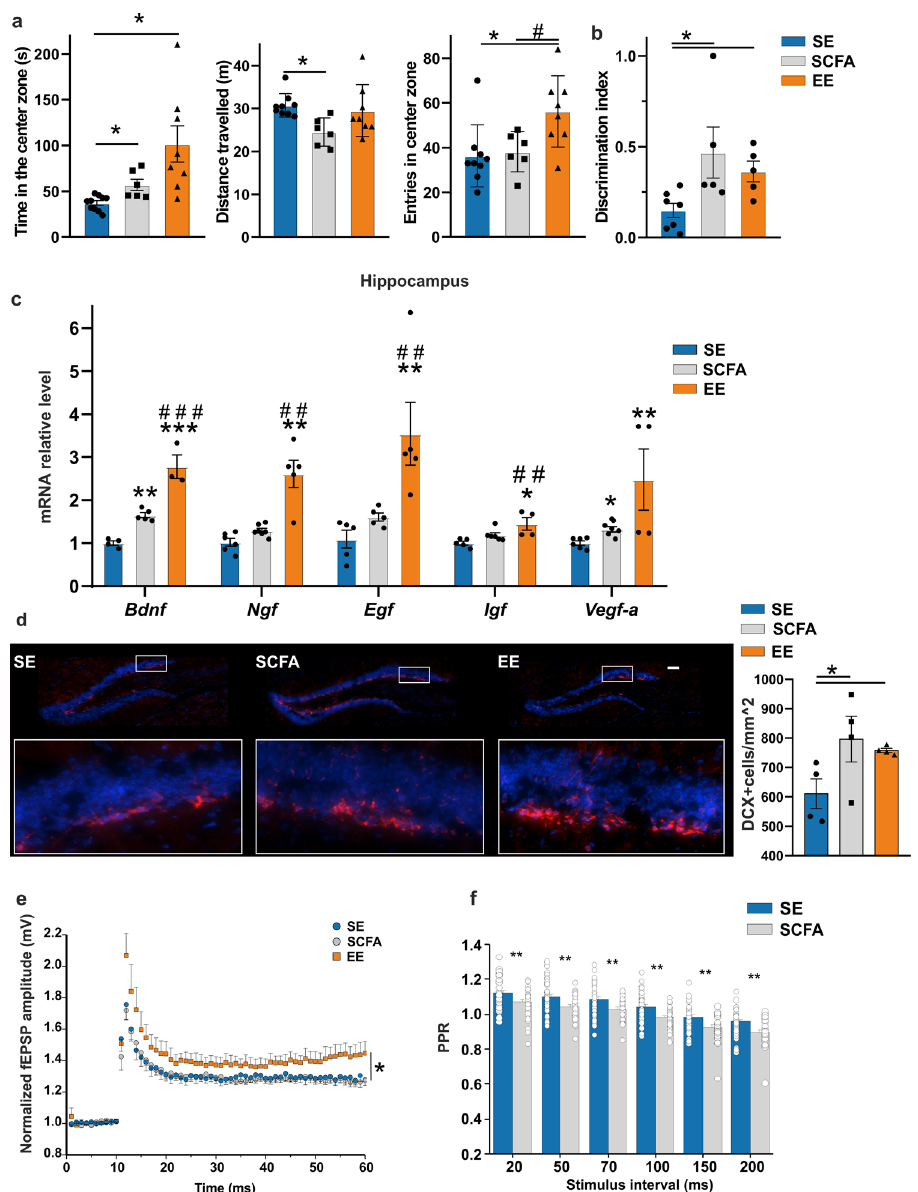
Fig. 3 Formate and acetate administration induces brain plasticity in EE-housed mice. a Open fi eld test for mice SE, treated with SCFA (150 mM sodium formate and 62.5 mM sodium acetate) or exposed to EE environment for 5 weeks: left panel, time (in seconds) spent in the center zone; central panel, distance traveled (in meters) during the test; right panel, number of entries in the center zone (* p -value < 0.05 vs SE; # p -value < 0.05 vs SCFA. Data are the mean ± S.E.M.). b Novel object recognition test for SE, SCFA and EE mice. The discrimination index was calculated as the amount of time spent exploring the novel object relative to the familiar object, divided by the total amount of time exploring both objects. SCFA and EE mice performed better than controls (* p -value < 0.05 vs SE. Data are the mean ± S.E.M.) c RT-PCR of hippocampal neurotrophins ( Bdnf, Ngf, Egf, Igf, Vegf-a ) in SE, SCFA- or EE treated mice (*** p < 0.001; ** p < 0.01; * p < 0.05 vs SE; ### p < 0.001; ## p < 0.01 vs SCFA. Data are the mean ± S.E.M.). d Representative 20x magni fi cation of mouse hippocampal dentate gyrus (DG) coronal sections stained for DCX (red) and Hoechst (blue) of SE, SCFA- and EE treated mice (scale bar, 100 μ m). The highlighted squares illustrate the DG regions digitally ampli fi ed where DCX + cells are shown. Right, bar graphs showing the number of DCX + cells for mm 2 in the DG of the three groups (* p -value < 0.05 vs SE. Data are the mean ± S.E.M.). e Field excitatory postsynaptic potentials (fEPSPs) recorded from the CA1 region of hippocampus of SE (blue), SCFA (gray), or EE (orange) mice following Schaffer Collateral high frequency stimulation (100 Hz, of 1 s duration, arrow). Points represent mean (± SEM) of normalized fEPSP amplitude slopes evoked every 20 s (* p < 0.05). f Paired-pulse ratio (PPR) for 20-50-70-100-150-200 ms inter-stimulus intervals. Bar histograms represent averaged values for SE and SCFA (** p < Dunnett ’ s post-hoc test) compared to SE (1.28 ± 0.03, n/N = 11 gut metabolites, we recorded the LTP induced by 100 Hz biologically independent samples/4 biologically independent stimulation of Schaffer Collateral inputs comparing control with animals), whereas EE mice have signi fi cantly increased LTP EE and SCFA-treated mice. As shown in Fig. 3e, mice receiving amplitude (1.41 ± 0.05, n/N = 6 biologically independent sam- SCFAs have similar LTP amplitude in the CA1 synapses ples/2 biologically independent animals, p = 0.046 vs SE by (1.28 ± 0.01, n/N = 10 biologically independent samples/4 biolo- ANOVA, Dunnett ’ s post-hoc test), as previously reported 34 . In gically independent animals, p = 0.99 vs SE by ANOVA,